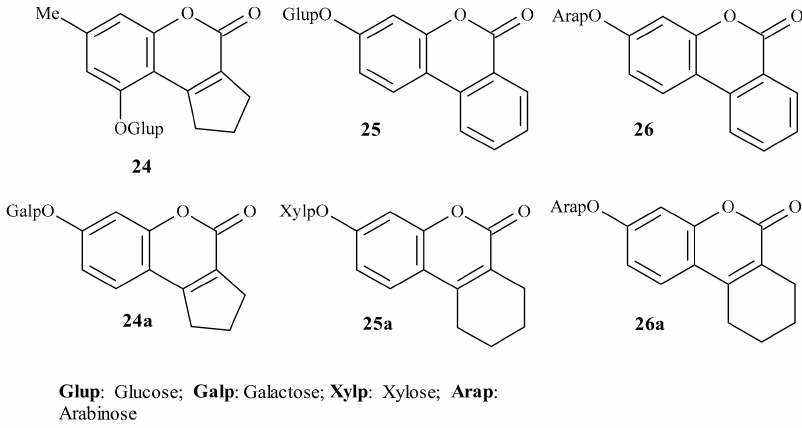
Figure 10. 5-Hydroxy- and 7-hydroxy-3,4-cycloannelated coumarin